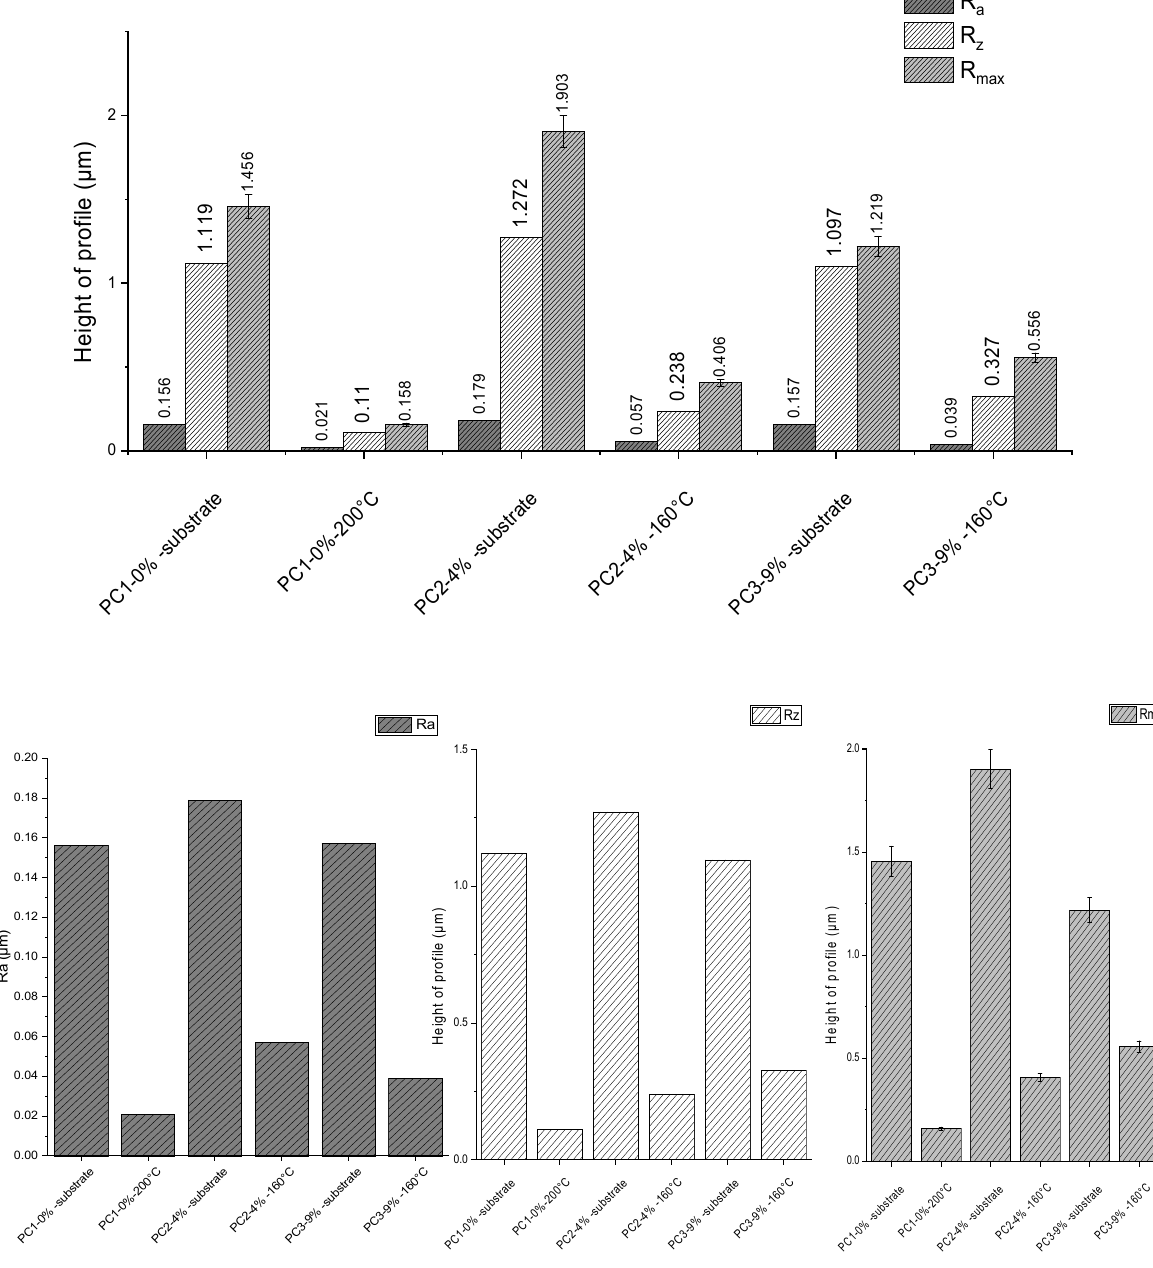
Figure 9. Roughness measurement results for substrate before and after coating for different systems.